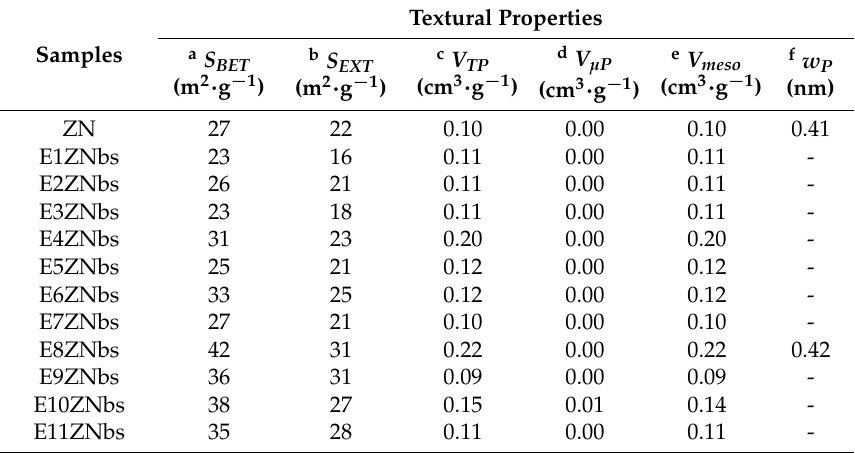
Table 3. Textural properties of natural zeolite and treated